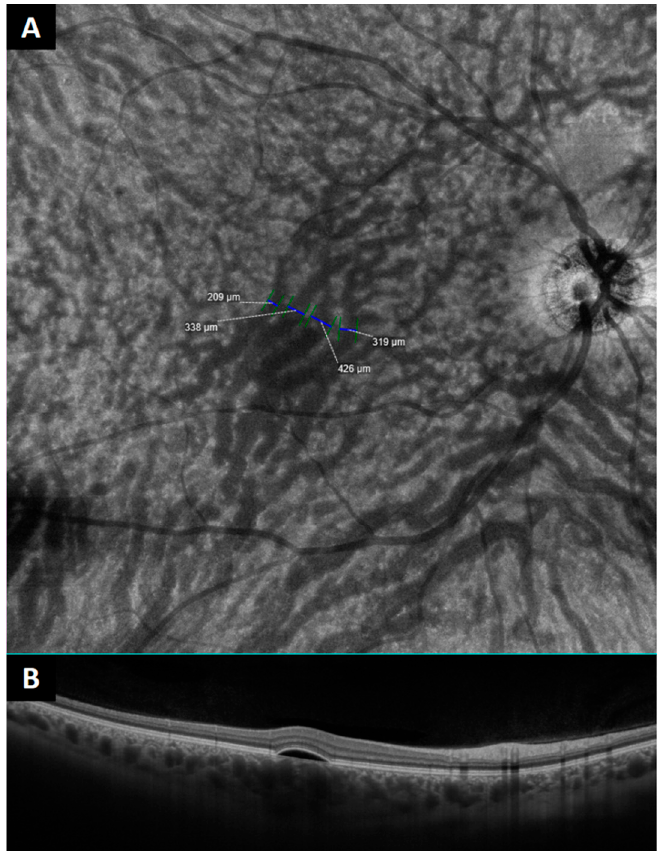
Figure 2. ( A ) En face optical coherence tomography of the macular region showing large anastomoses in a patient affected by central serous chorioretinopathy (CSCR). ( B ) B-scan showing the pachyvessels on the choroid in the central area.